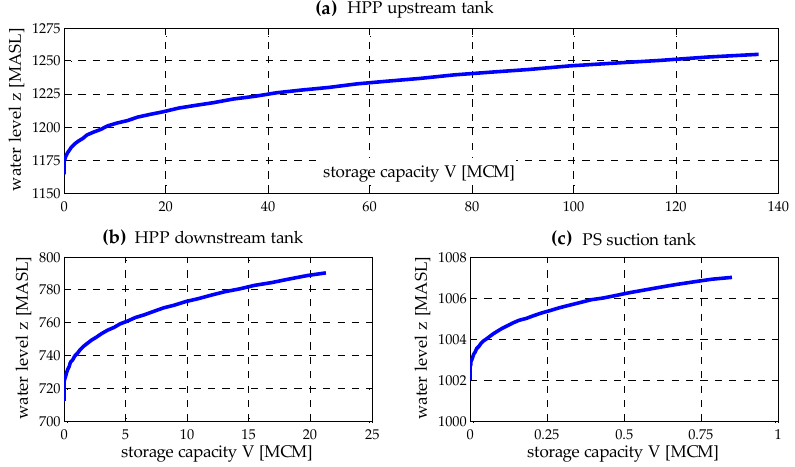
Figure 5. Tanks’ capacity curves used in the numerical model: ( a ) HPP upstream tank; ( b ) HPP downstream tank; ( c ) PS suction